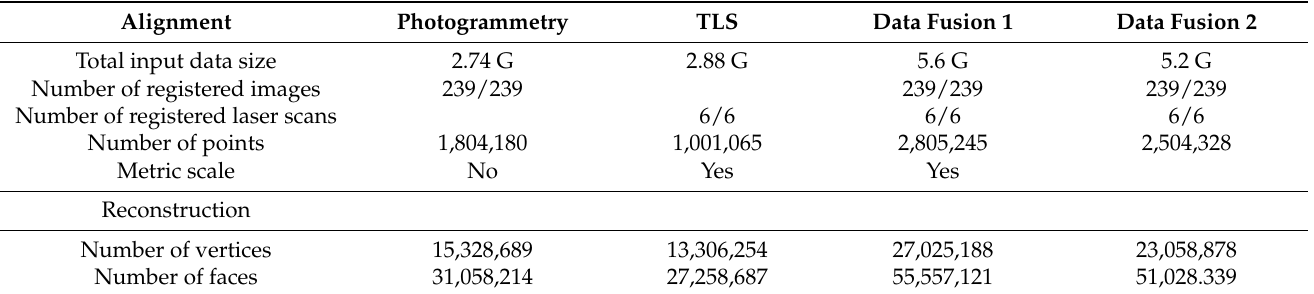
Table 5. A summary of results of the different methods.